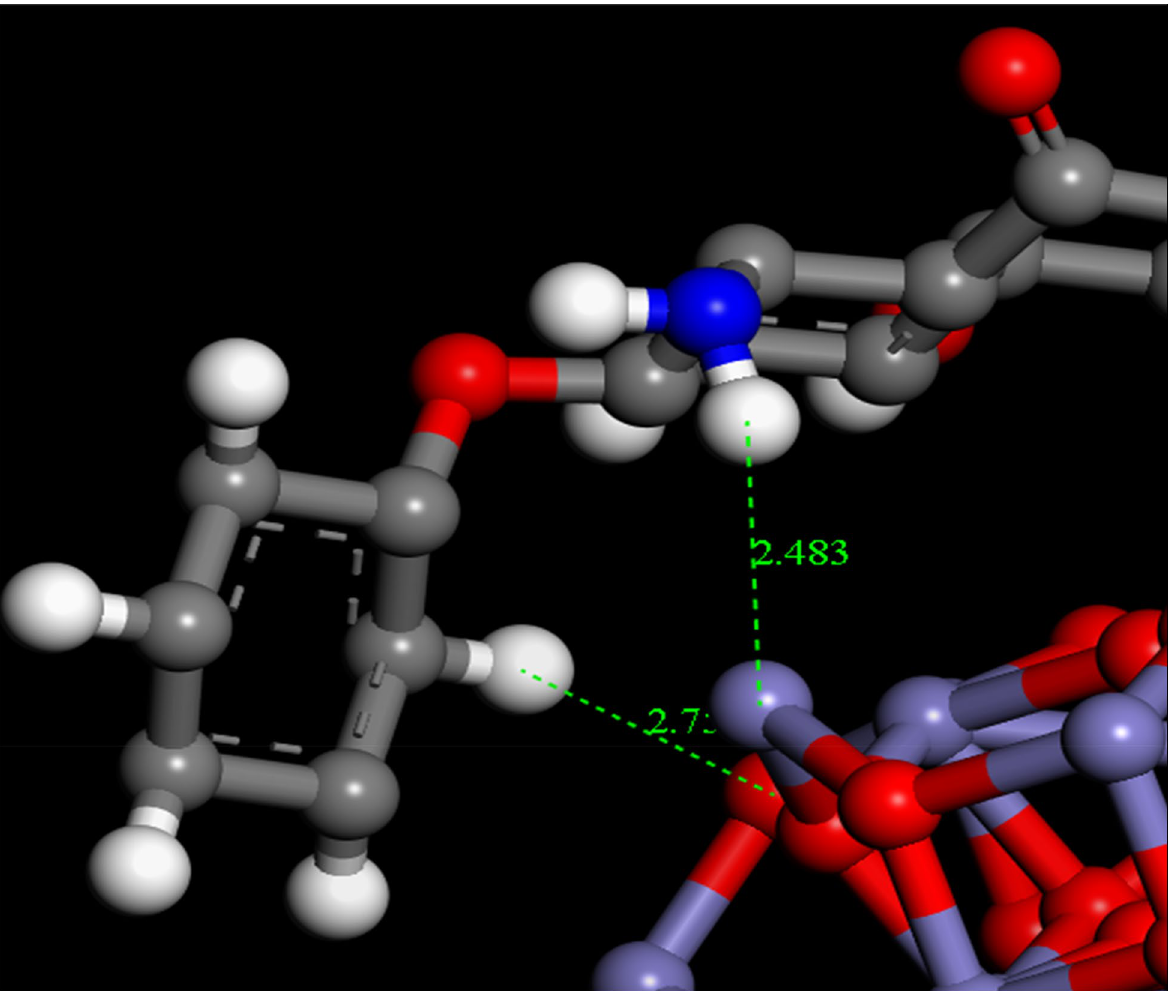
Figure 15. Snapshots for the adsorption configurations of DR adsorbed on CF-1 nm, the bond length is in